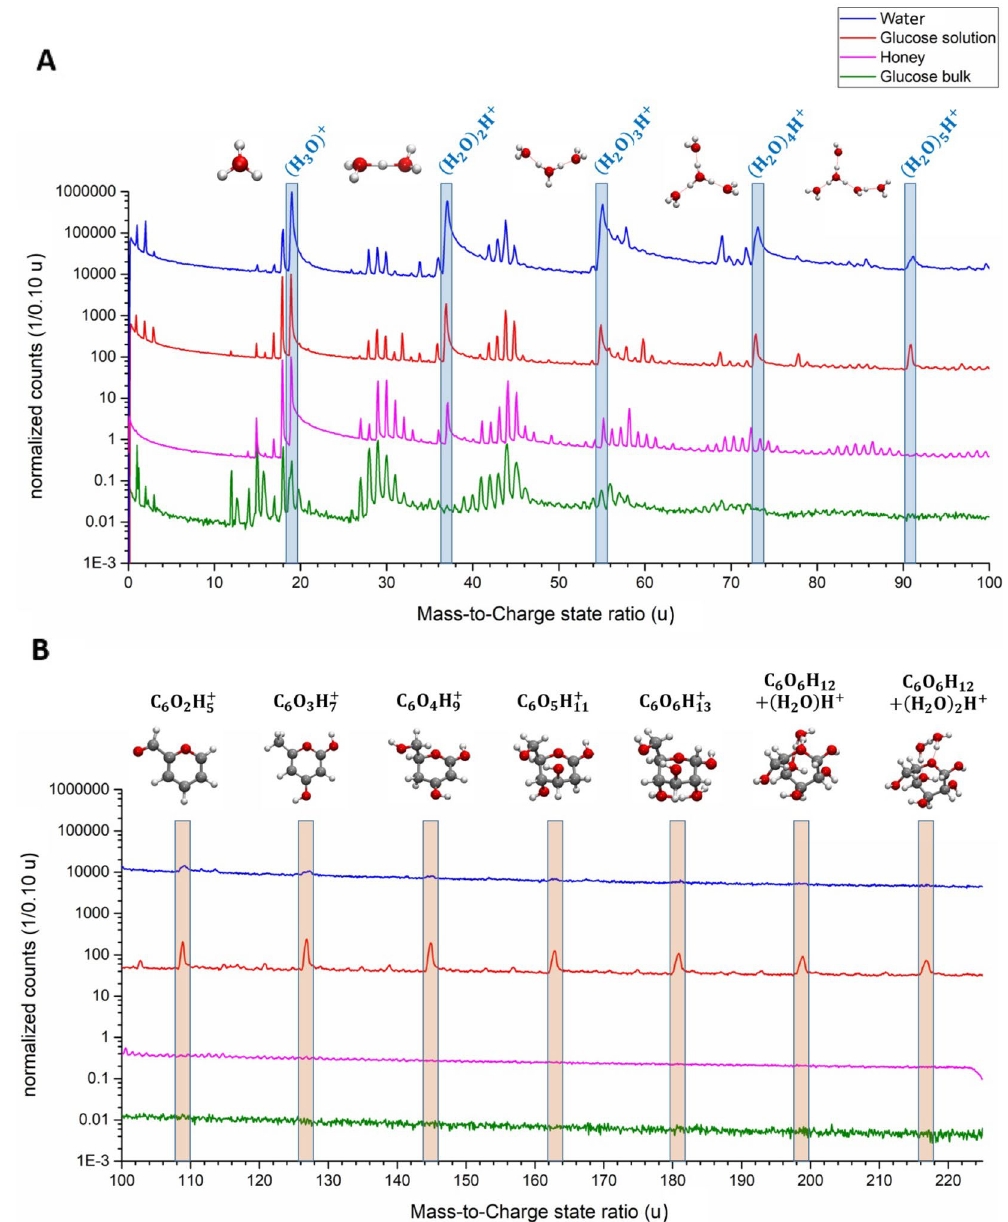
Figure 2. Comparison of the mass spectra of pure water (blue), a saturated glucose solution (red), glucose as bulk material (green) and honey (purple). All mass spectra are normalized to the respective highest peak from the mass-to-charge state ratio of m/q = 0–110 u as a logarithmic plot. The water spectra were shifted upwards by a factor of 10 6 , glucose solution by 10 4 and honey by a factor of 10 2 to improve the visibility of the mass spectra. In ( A ) The protonated water molecules/clusters are highlighted and the respective molecular structure of (H 2 O) n H + with n = 1–5 is shown. In ( B ) the peaks stemming from glucose from m/q = 91 up to 217 u are marked and the respective molecular structures are